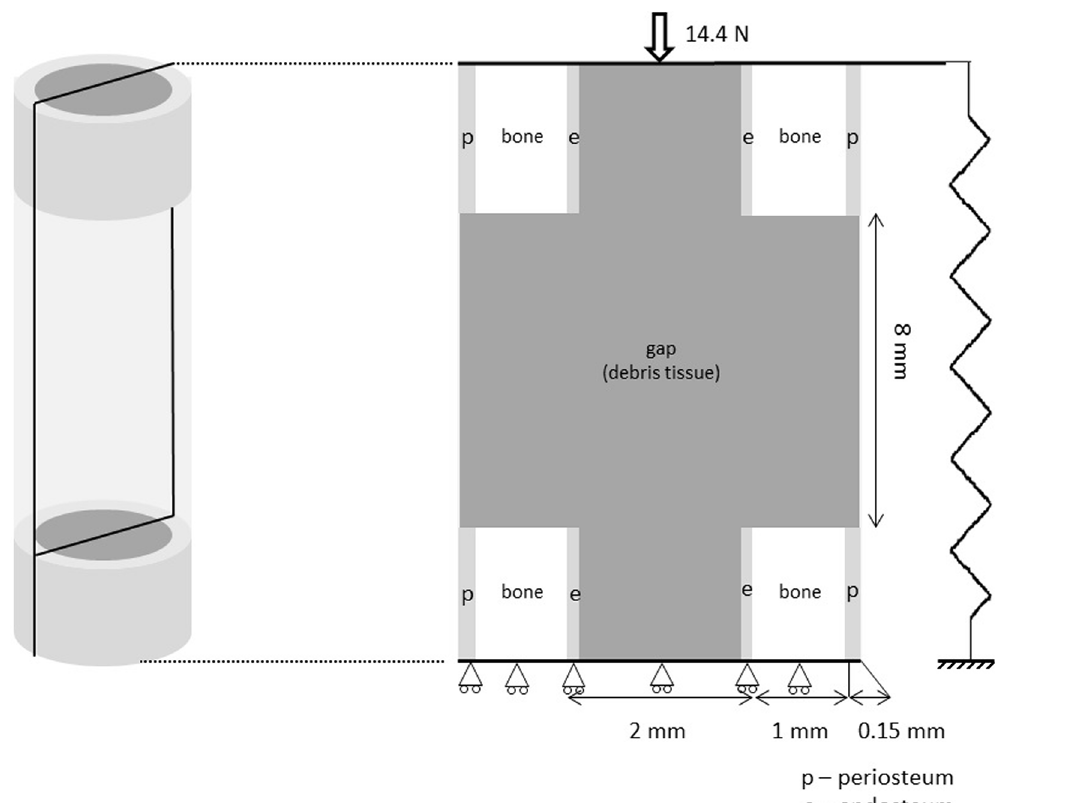
Fig 5. Rat idealised geometry with the respective dimensions, different bone parts and load.